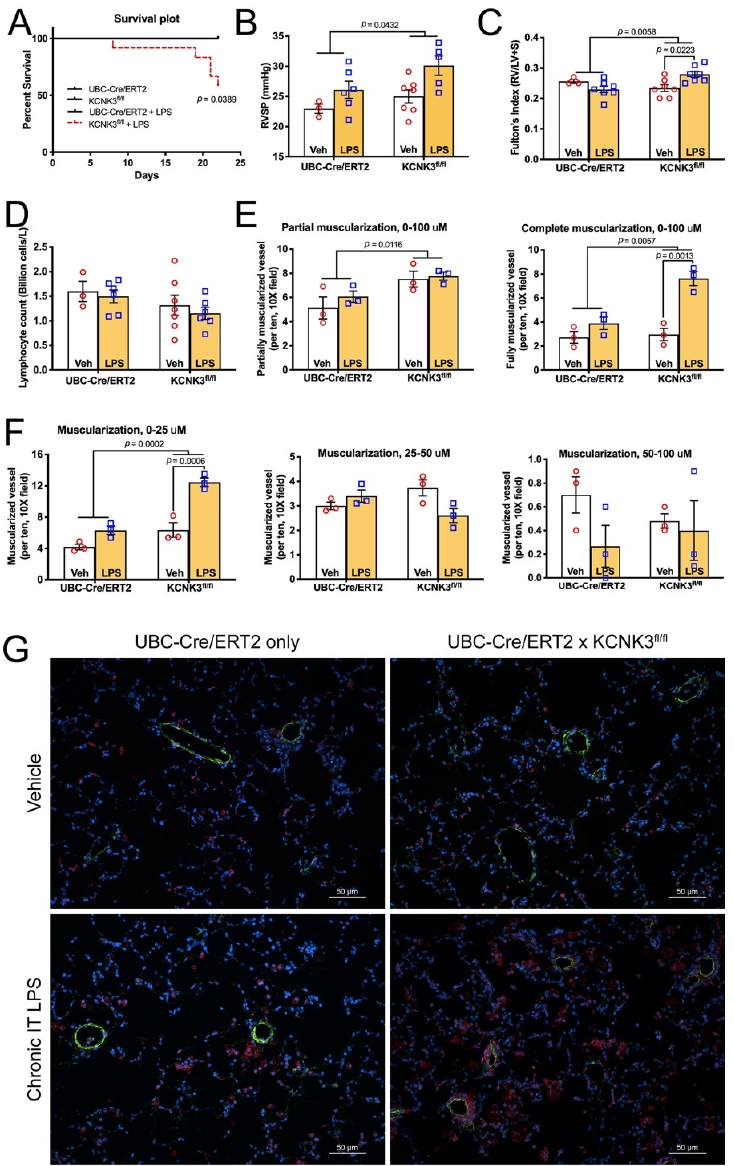
Figure 4. Kcnk3 fl/fl mice have heightened susceptibility to inflammatory insult. ( A ) Kcnk3 fl/fl mice have much higher mortality (5/12 compared to zero) compared to control mice treated with low dose LPS. All mice carried the UBC-Cre/ERT gene and were Tamoxifen treated. ( B ) Kcnk3 fl/fl mice that survived had elevated RVSP. ( C ) Kcnk3 fl/fl mice treated with low dose LPS also had elevated right ventricular hypertrophy, proportional to pressures. ( D ) There were no differences in white blood counts between groups (lymphocytes shown as an example). ( E ) Partially and fully muscularized vessels per field were increased in kcnk3 fl/fl mice. ( F ) Numbers of muscularized vessels were increased in <25 μ m but not larger vessels in kcnk3 fl/fl mice. ( G ) Immunofluorescence depicting increased numbers of muscularized vessels (actin, green) and increased CD45 positive inflammatory cells (red) in kcnk3 fl/fl mice.